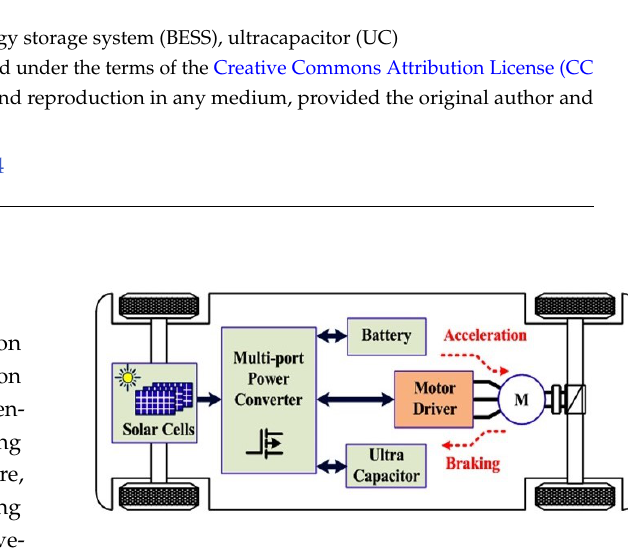
Fig. 1. Functional diagram of an electric vehicle system as batteries, ultra-capacitors, and solar panels can be used to achieve high power in EV during acceleration and in regenerative braking also. The exchange of energy between such sources in EV can be controlled by the proper design of power electronic